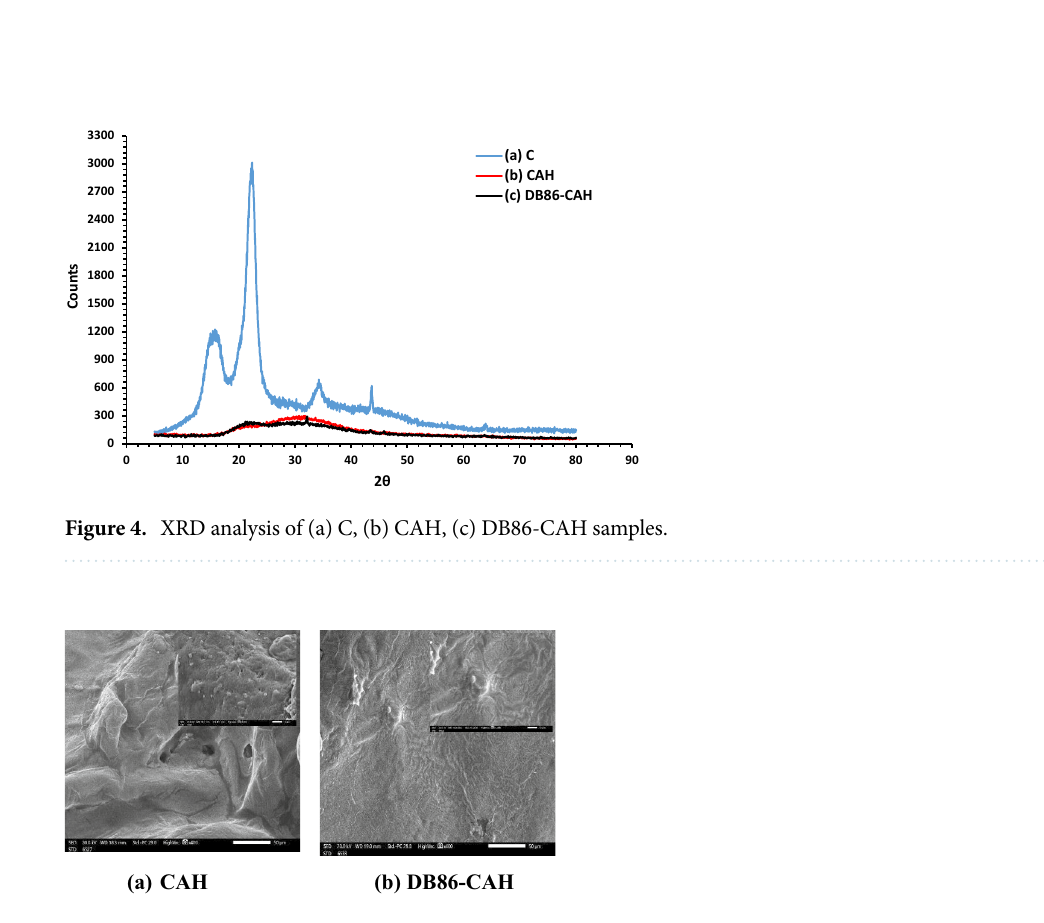
Figure 5. SEM images ( a ) CAH sample, ( b ) DB86-CAH